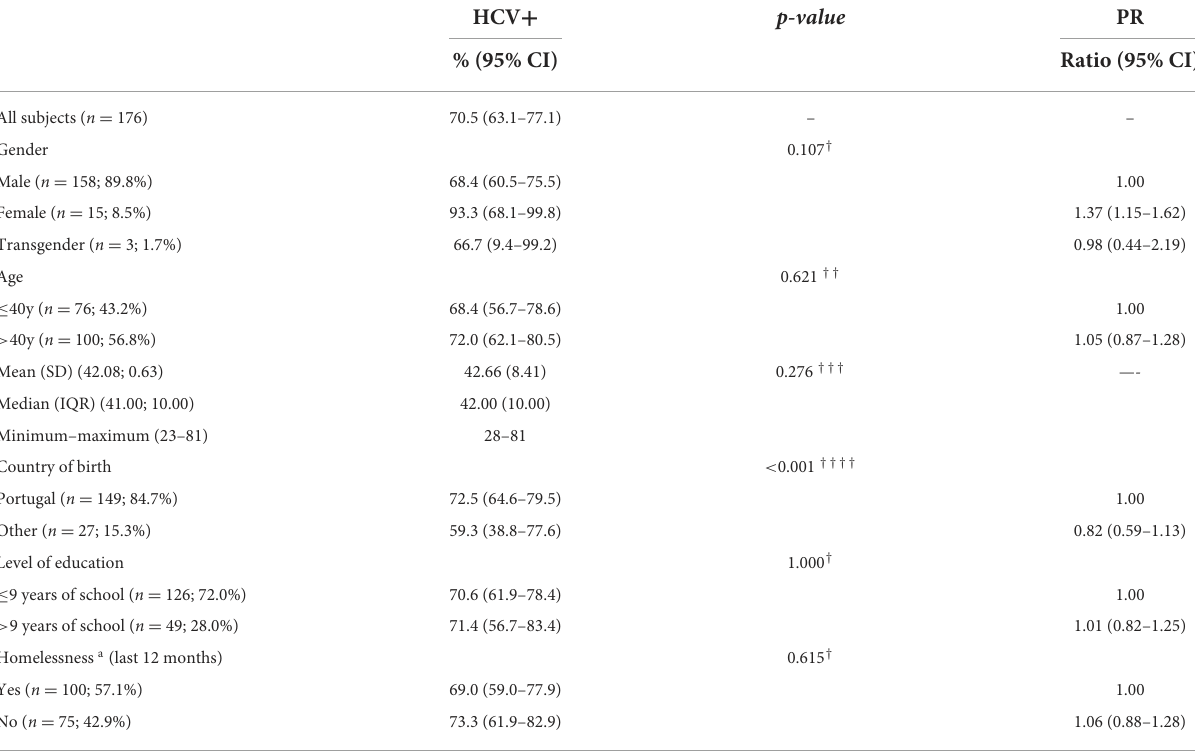
TABLE 1 Sociodemographic characteristics of the